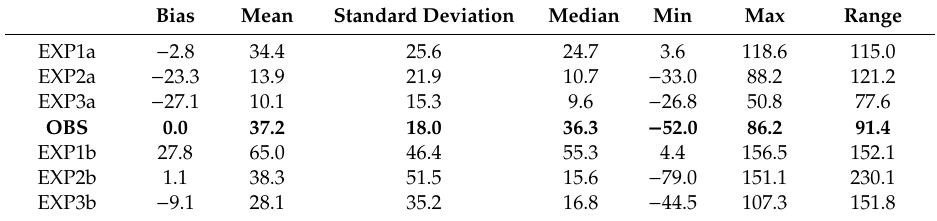
Table 5. Sensible Heat Flux (SHF) (W m − 2 ) simulated and observed at the CF station (data number 271).